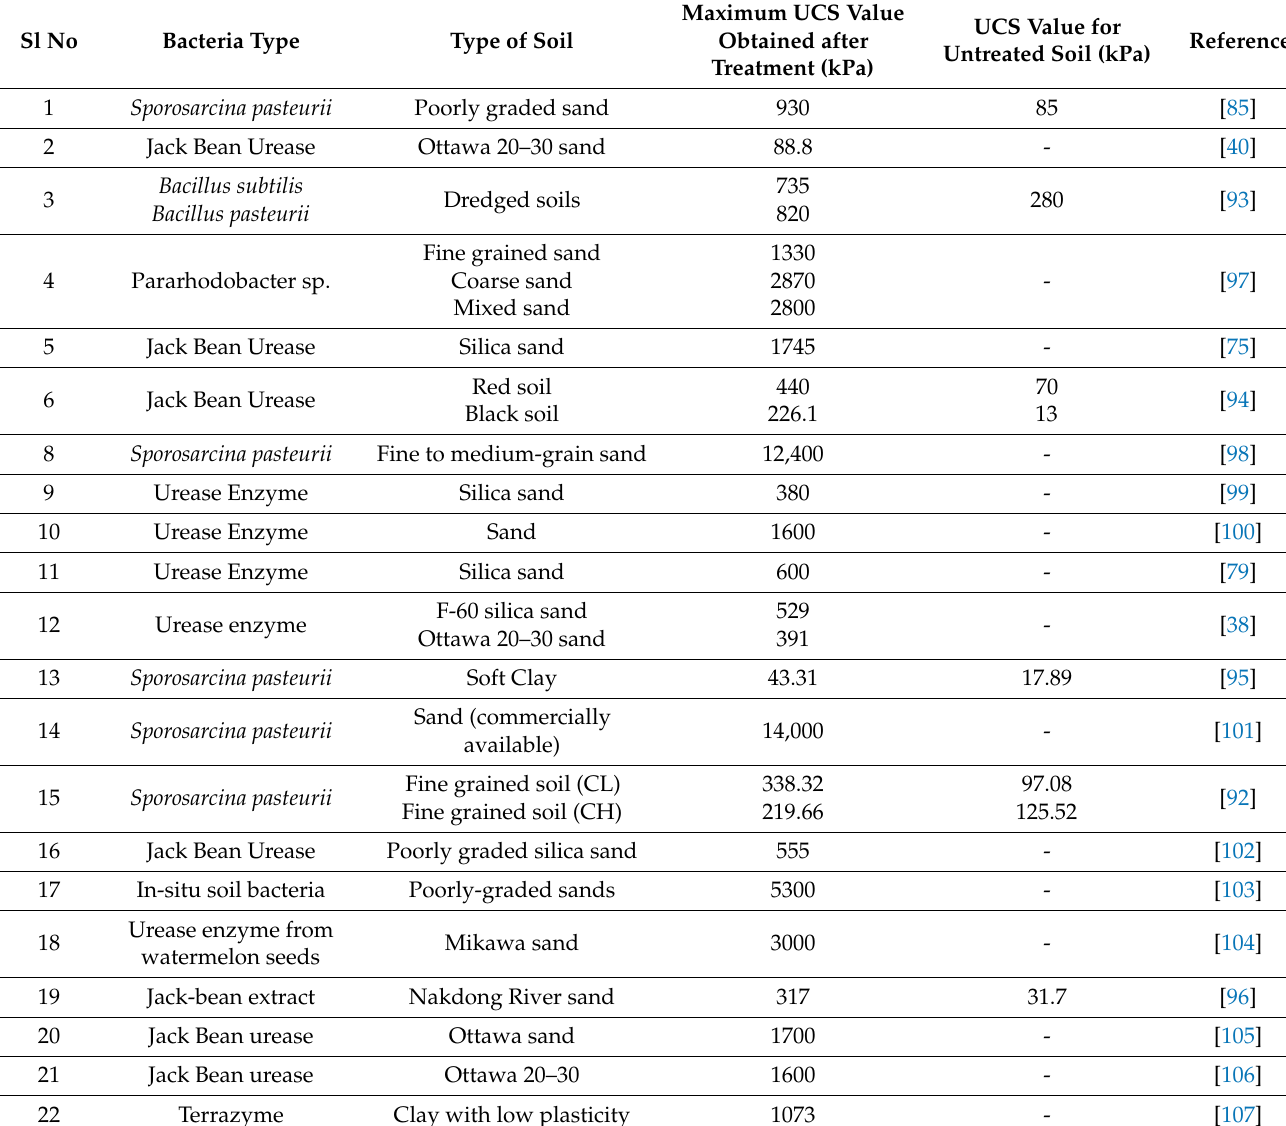
Table 1. Unconfined Compressive Strength (USC) results obtained by different researchers after the biotreatment of